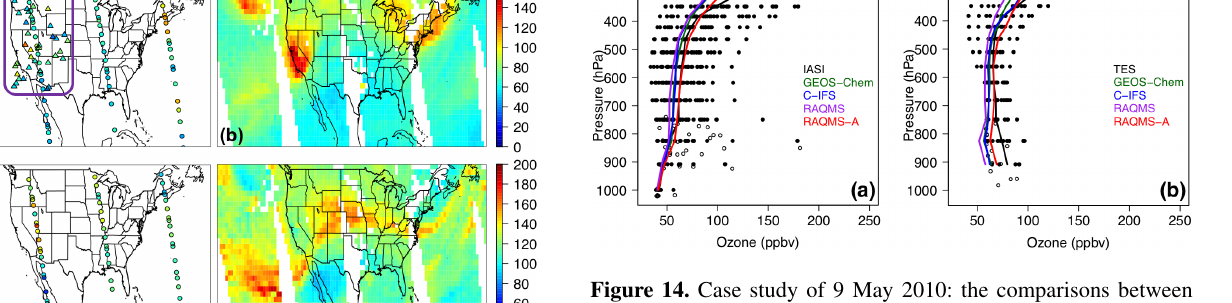
Figure 14. Case study of 9 May 2010: the comparisons between (a) IASI and (b) TES O 3 in the western US with the simulated O 3 in the STEM runs using the GEOS-Chem (green), C-IFS (blue), RAQMS (purple), and assimilated RAQMS (red) boundary condi- tions. The O 3 profiles within the purple box in Fig. 13a were used in the evaluation. Observation operators were applied in the compar- isons (details in Sect. 2.3.2). Solid and open dots are TES or IASI data at the TES retrieval reporting levels and at the variable sur- face pressure levels, respectively. Solid lines are median O 3 profiles from the satellite observations and the different STEM simulations, calculated only on the TES retrieval reporting